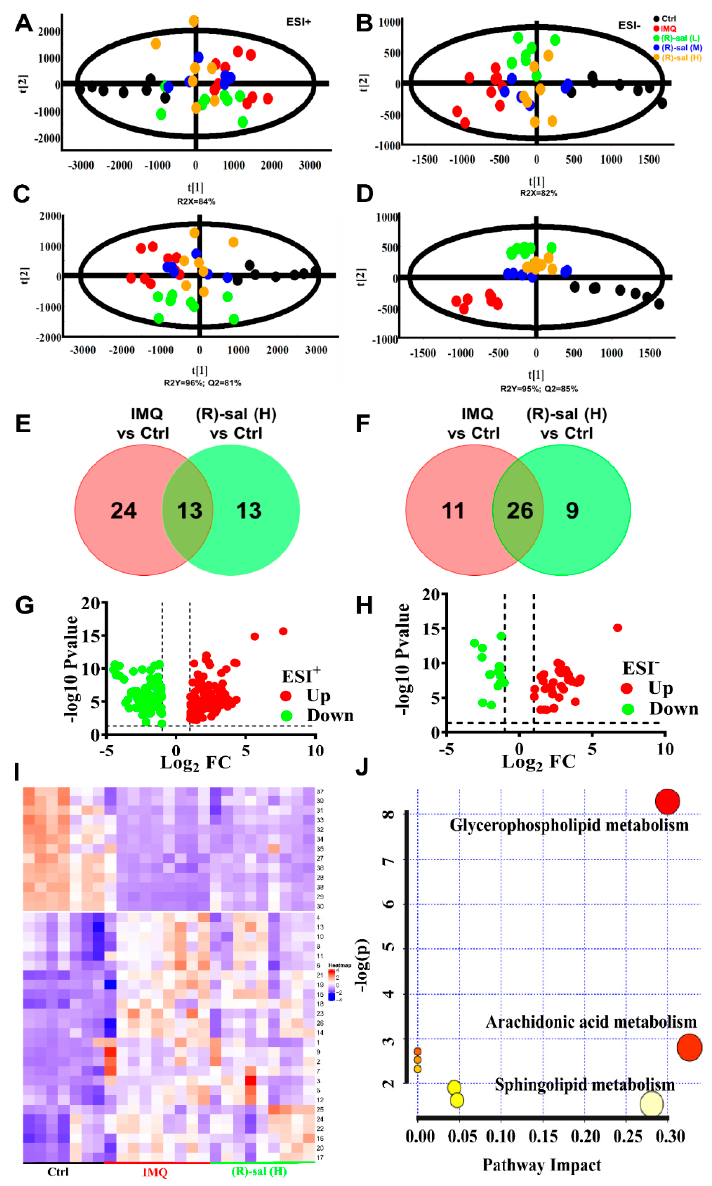
Figure 7. Results of the metabolic e ff ects of ( R )-salbutamol in mice treated with IMQ to induce psoriasis. ( A , B ) PCA plot scores for the control, IMQ and ( R )-salbutamol (L, M, H) groups in ( B ) ESI ( − ) mode and (A) ESI ( + ). ( C , D ) PLS-DA score plot for the ( R )-salbutamol (L, M, H), IMQ and control on the basis of mice plasma metabolic profiles for the ( D ) ESI ( − ) mode and (C) ESI ( + ). ( E , F ) Venn diagrams showing the upregulated ( E ) or downregulated metabolites ( F ) based on the binary comparison of ( R )-salbutamol vs. control, IMQ vs. control corresponding to the numbers shown in Supplemental Table S4. ( G , H ) Volcano plots of p values in the ( G ) ESI ( + ) and (H) ESI ( − ) mode. ( I ) Visualization of candidate biomarkers among the ( R )-salbutamol, IMQ, and control in the ESI ( + ) and ESI ( − ) mode using Heat map of unsupervised hierarchical clustering. Columns: samples; Rows: biomarkers. The content level of metabolites is denoted by the color key. Red stands for high metabolite level whereas blue color denotes low metabolite level. ( J ) Pathway analysis for the di ff erential metabolism in the ( R )-salbutamol (L, M, H), IMQ, and control groups based on the topology analysis ( x -axis) and enrichment analysis scores ( y -axis). The size and color of each circle represent the pathway impact factor and p -value, respectively. The pathways marked in red are the most significant. These analyses were performed using the MetaboAnalyst 4.0